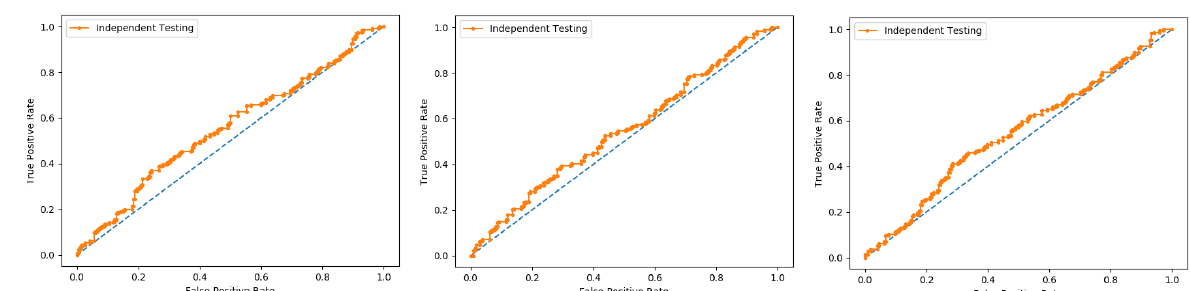
Figure 14. Independent Probabilistic Neural Network ROC